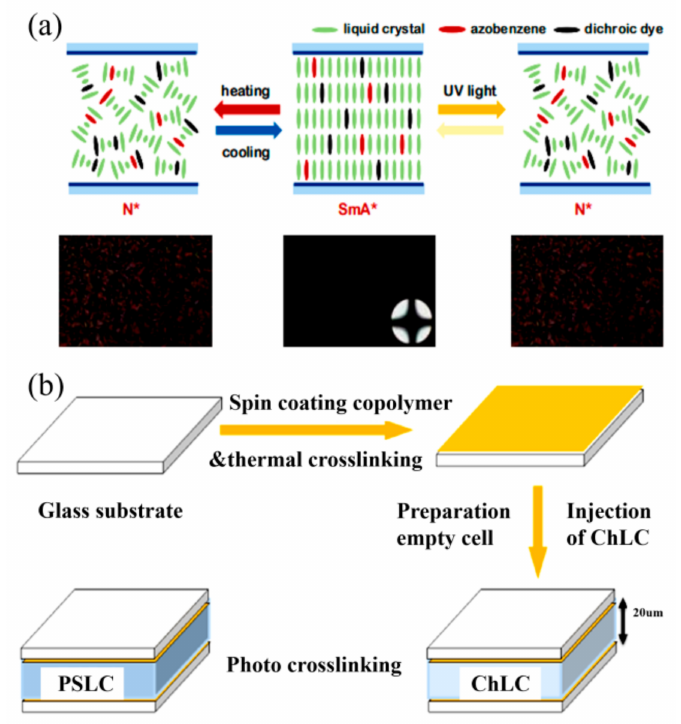
Figure 4. ( a ) Self-occlusion shutter schematic and POM images [36]. ( b ) Preparation process of polymer-stabilized liquid crystal (PSLC) smart window. Reproduced with permission from [37]. Copyright 2017, American Chemical